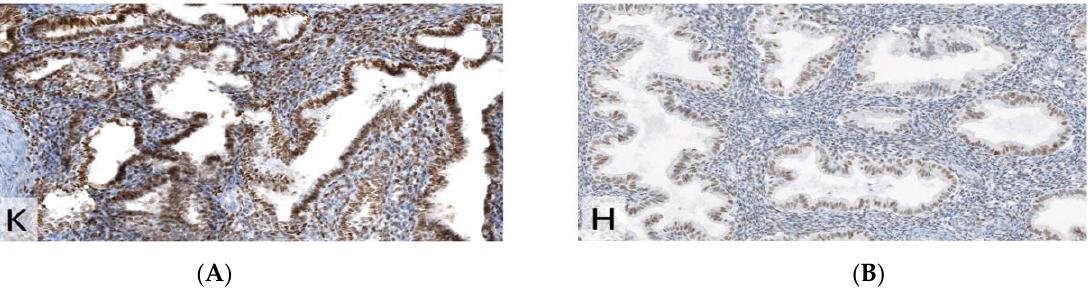
Figure 8. Estrogen receptor (ER) with heterogeneous moderate to strong expression in 75% of the epithelium ( × 200). ( A ) Endometriosis. ( B ) Endometrium.